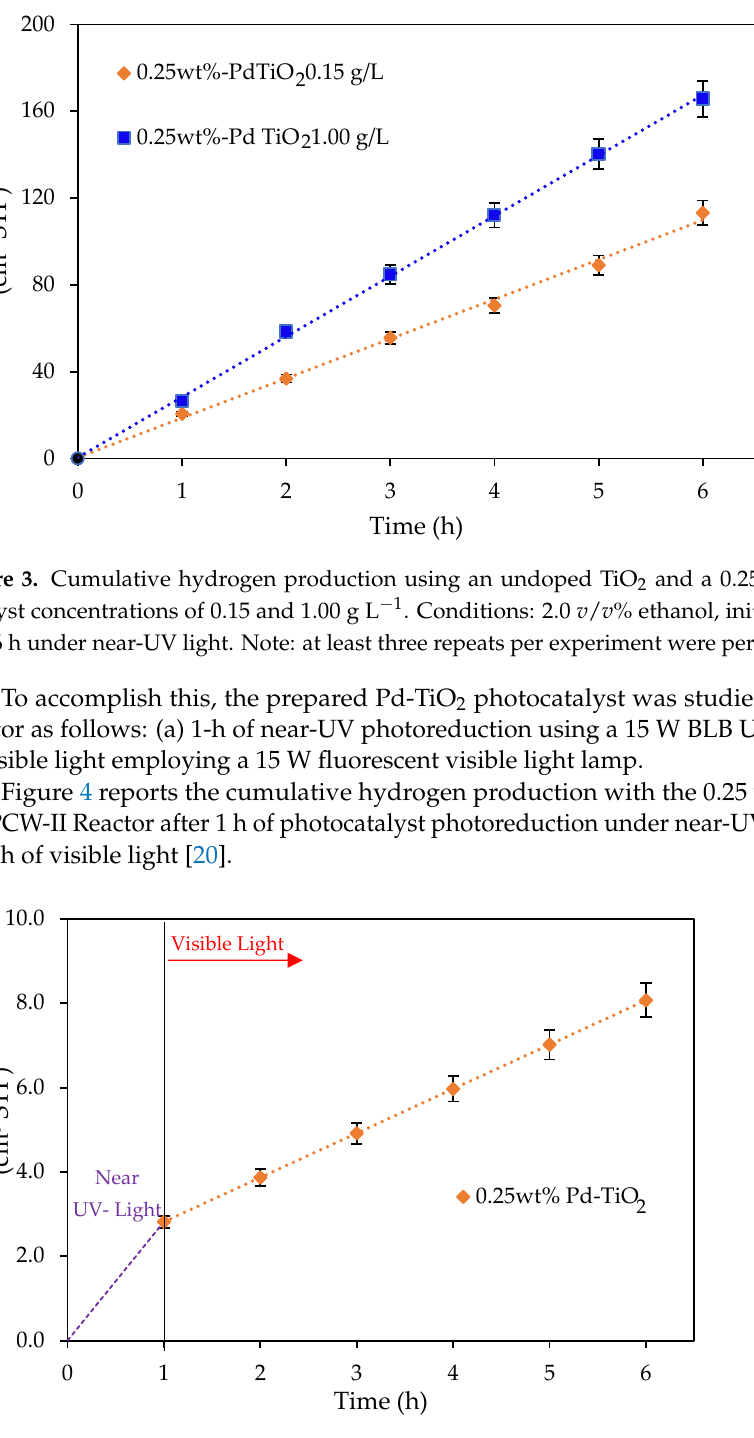
Figure 4. Cumulative formed hydrogen using 0.25 wt% Pd-TiO 2 and a 0.15 g L −1 photocatalyst concentration. Conditions: 1 h near-UV light photoreduction; 5 h of visible light; 2.0 v / v % ethanol; initial pH = 4 ± 0.05. Note: at least three repeats per experiment were performed.